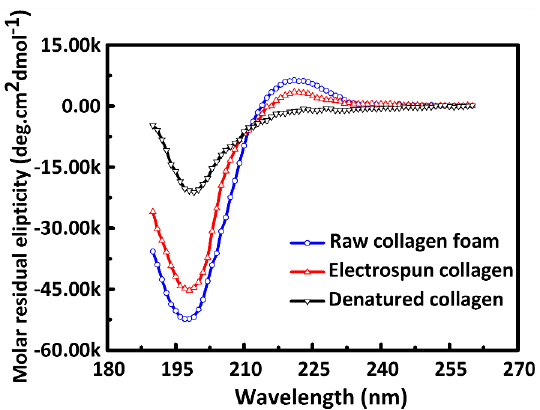
Figure 1. Circular dichroism spectra (baseline subtracted) of raw collagen, electrospun collagen and denatured collagen.